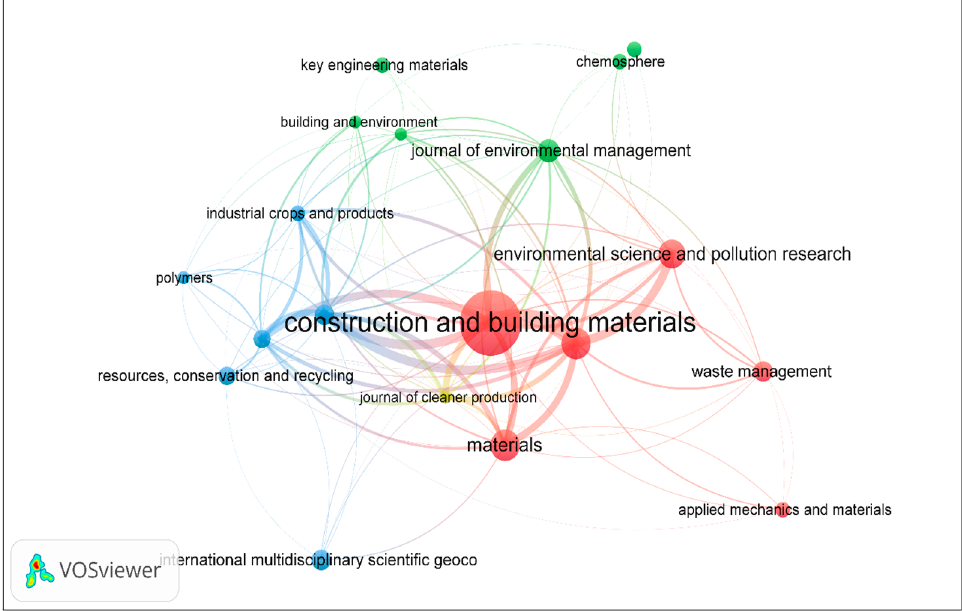
Figure 6. Source occurrences map. Table 3. Quantitative summary of impact of sources.